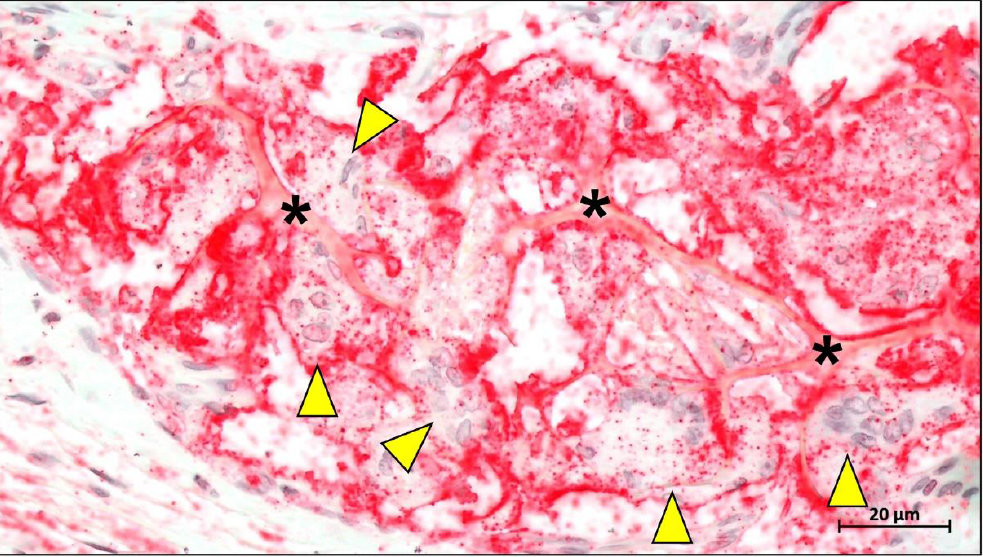
Figure 11. Representative histological image showing strong pro-inflammatory tissue reaction (red staining) mainly involving multinucleated giant cells (yellow arrowheads) to a GA crosslinked collagen membrane (asterisks = material remnants) within the subcutaneous connective tissue at 2 weeks post implantationem. (CD11c immunostaining, 400× magnification, scalebar = 20 µm).